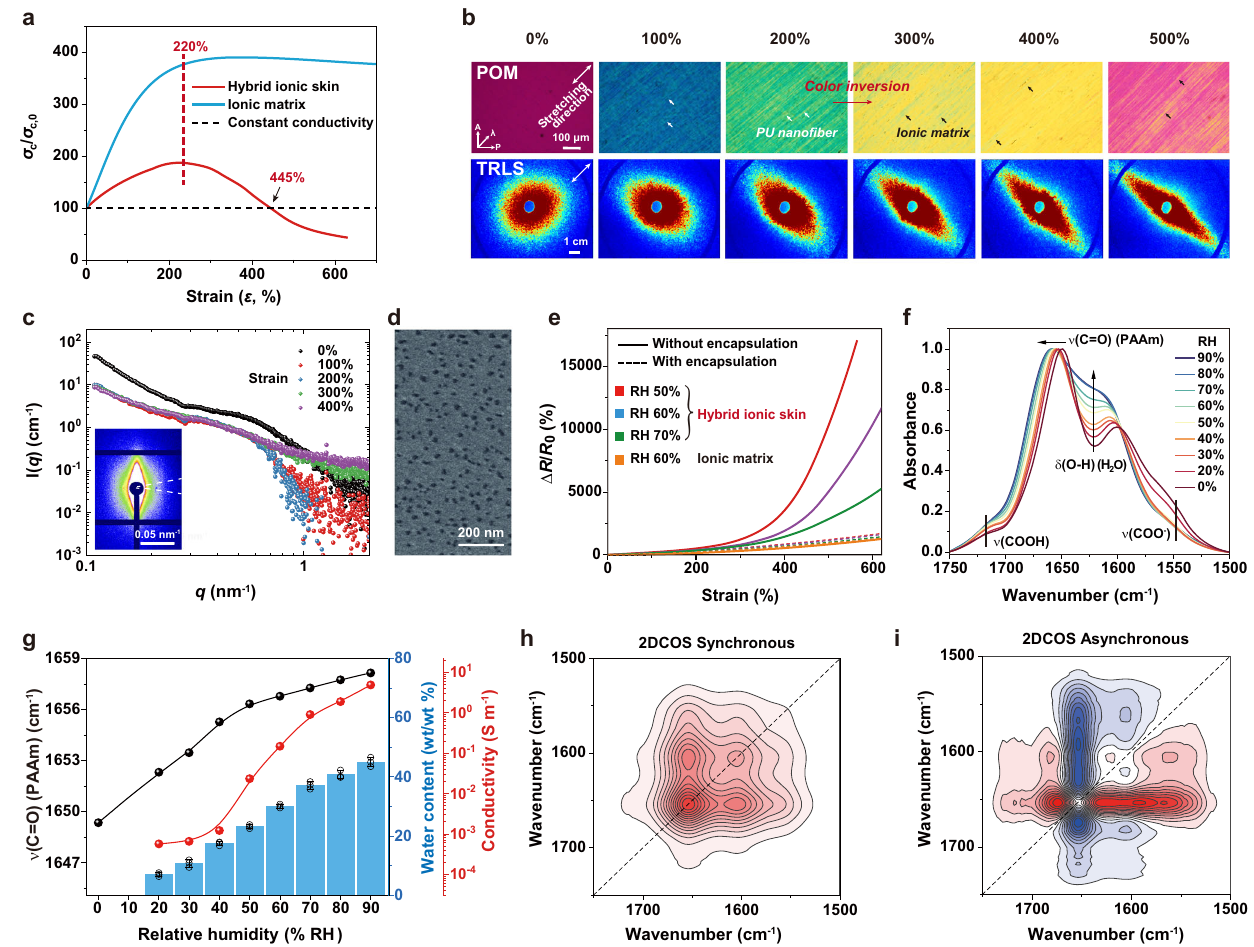
Fig. 5 | Mechanism analysis for the enhanced strain sensation of hybrid ionic skin. a Strain-dependent ionic conductivity changes ( σ c / σ c,0 ) of hybrid ionic skin, ionic matrix, and conductivity-constant conductor. b POM images (top) and 2D TRLS patterns (bottom) of hybrid ionic skin with increasing strains. c SAXS scat- tering intensity plots of hybrid ionic skin at increasing strains (inset: 2D pattern at 200% strain showing the horizontal integral direction). d SEM image of vacuum- dried ionic matrix. e Strain-dependent resistance changes of hybrid ionic skin and ionic matrix equilibrated at different humidities and with/without VHB